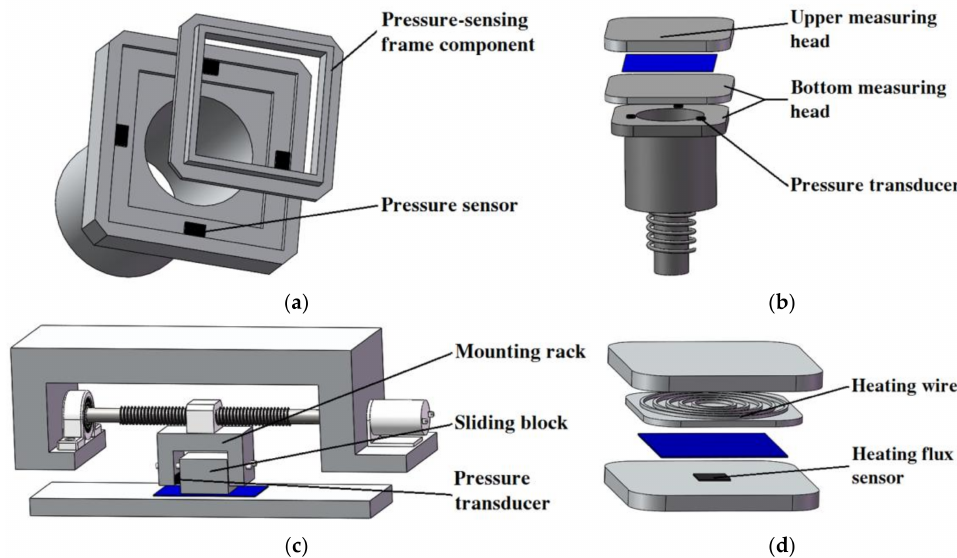
Figure 2. Integration measurement of tactile characteristics of four dimensions: ( a ) bending; ( b ) compression; ( c ) friction; ( d ) thermal